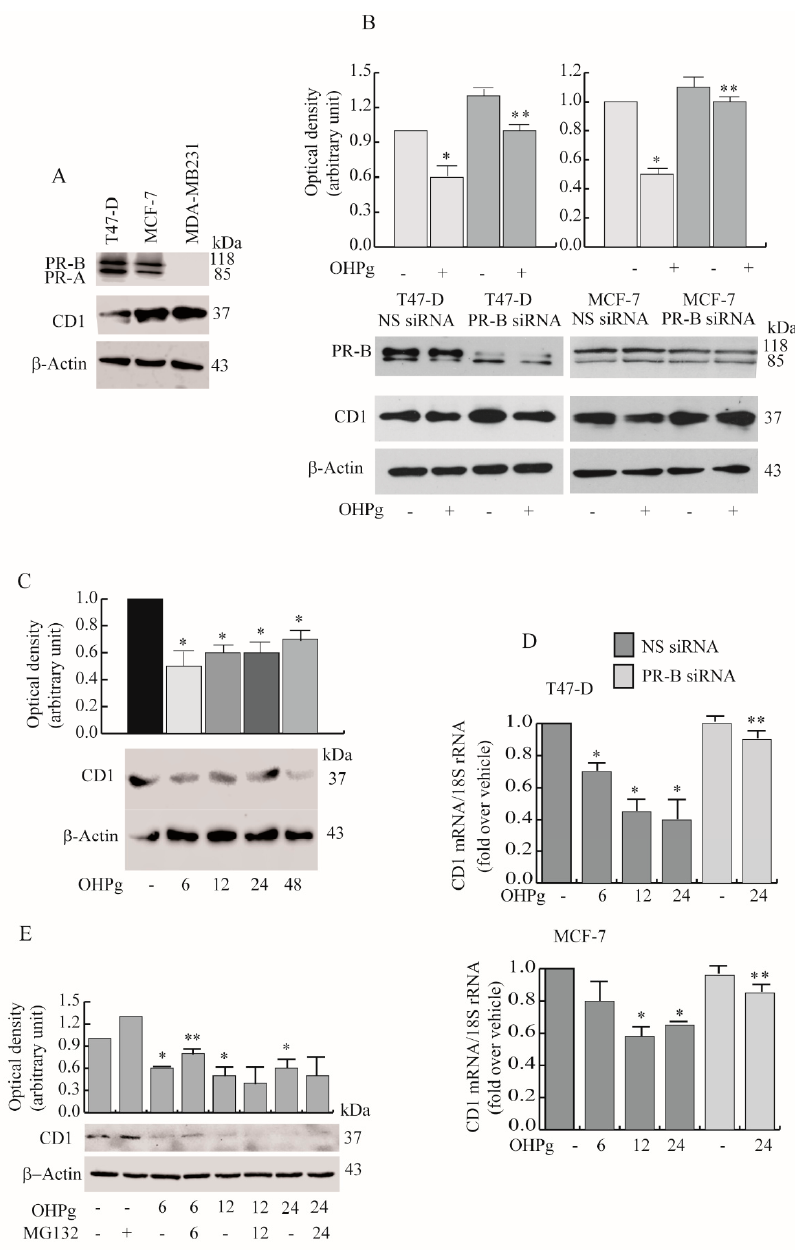
Figure 3. OHPg-treated breast cancer cells show a reduction of the cytoplasmic cyclin D1 (CD1) amount. ( A ) Immunoblot analyses for PR-B, progesterone receptor A (PR-A), CD1 expression in indicated cells and ( B ) in T47-D and MCF-7 cells transfected as indicated. Columns are the mean of three independent experiments in which CD1 band intensities were evaluated in terms of optical density arbitrary units, and expressed as fold over vehicle-treated NS siRNA cells, which was assumed to be 1; bars, SD. * p ≤ 0.05 vs. vehicle-treated NS siRNA cells. ** p ≤ 0.05 vs. OHPg-treated NS siRNA cells. ( C ) Immunoblot analyses for CD1 expression in MCF-7 cells treated at different times (h) as indicated by numbers. * p ≤ 0.05 vs. vehicle-treated cells. ( D ) Real-time polymerase chain reaction (PCR) assay of CD1 mRNA expression in T47-D (upper panel) and MCF-7 cells (lower panel), transfected and treated at di ff erent times as indicated. 18S rRNA was determined as the control. * p ≤ 0.05 vs. vehicle treated NS siRNA cells. ** p ≤ 0.05 vs. 24 h OHPg-treated NS siRNA cells. ( E ) Immunoblot analyses for CD1 expression.MCF-7 cells were pretreated with MG132 for 2 h and then co-treated with OHPg at di ff erent times (h) as indicated by numbers. * p ≤ 0.05 vs. vehicle-treated cells. ** p ≤ 0.05 vs. OHPg-treated